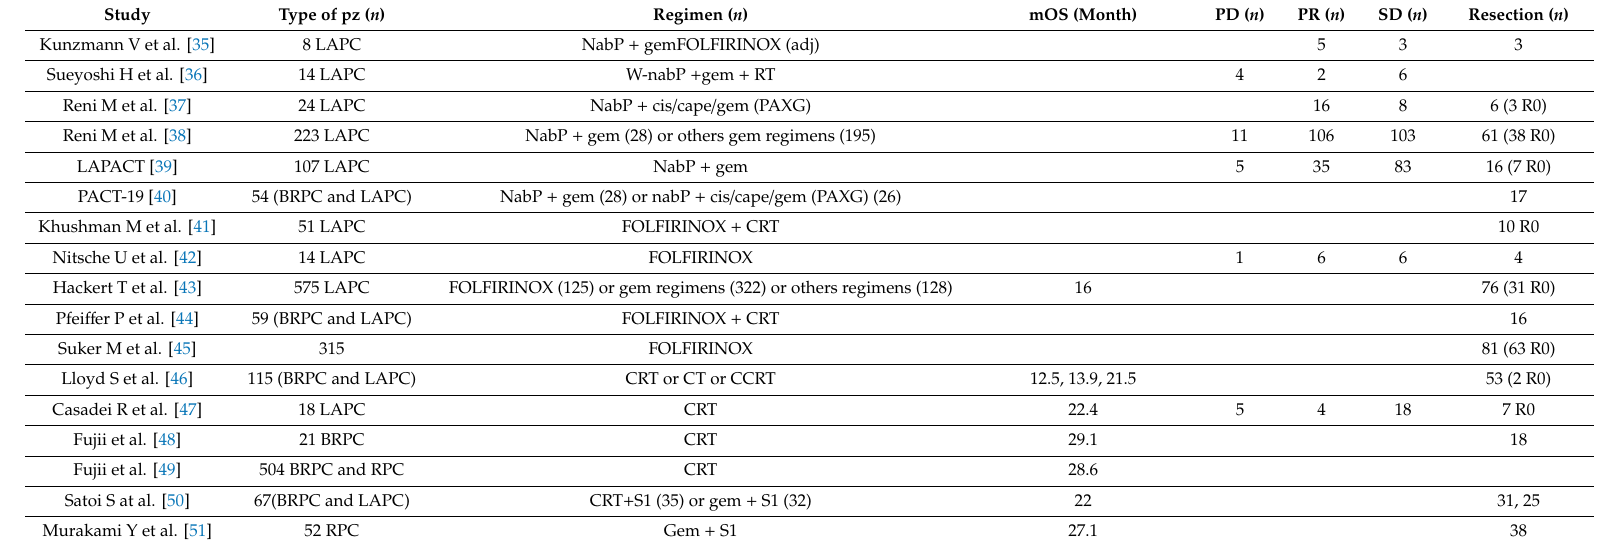
Table 2. Summary of prospective and retrospective trials to assess the e ffi cacy of neoadjuvant treatments (not cited in the